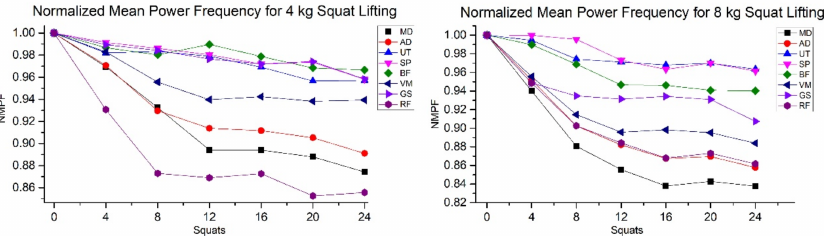
Figure 4. Normalized mean power frequencies (NMPF) for the eight muscles. Medial deltoid (MD), anterior deltoid (AD), upper trapezius (UT), supraspinatus (SP), bicep femoris (BF) vastus laterals (VS), gastrocnemius (GS), and rectus femoris